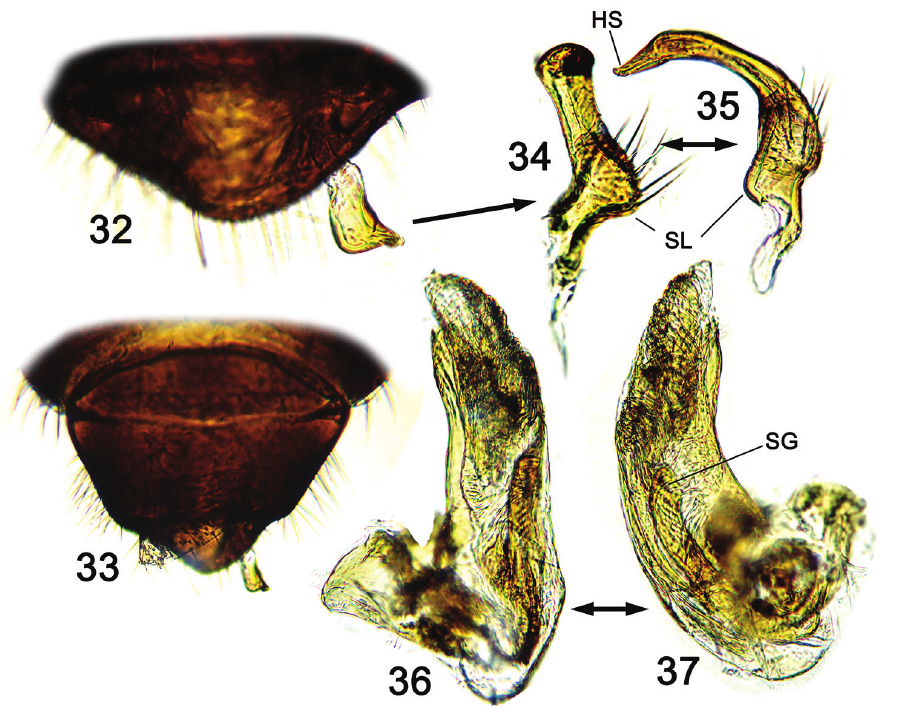
middle portion of segment II sometimes pale; base of segment III pale. Labium yel- lowish brown except tip brown, reaching anterior margin of mesosternum. Pronotum dark brown with yellowish quotation mark-shaped markings, strongly convex and distinctly punctate, densely covered with long erect yellowish setae; collar yellowish brown with dark base punctate, length 0.56 of width; triangular yellowish marking on mesal calli; short longitudinal whitish stripe on base of disc; posterior margin narrowly pale; areas between punctures on disc somewhat swollen but not calloused; prosternum yellowish brown, conically projecting. Scutellum entirely dark, gradu- ally elevated to posterior with rounded carinate process; meso- and metapleura dark except for ostiolar peritreme whitish yellow. Hemelytron smooth, shiny and transpar- ent with two transverse brown bands; anterior 1/4 and posterior half dark brown; mesal half of posterior end of corium brown, both sides of marking connected with posterior transverse band; posterior part of embolium narrowly brown; posterior part of cuneus and membrane veins tinged with brown. Legs pale yellowish brown; hind femur with apical 1/3 brown or with red band. Abdomen almost entirely dark brown in male, lateral half of segments II, IV and VII yellowish brown in female; marking on female segment II convex. Male genitalia as in Figs 32–37. Sensory lobe of